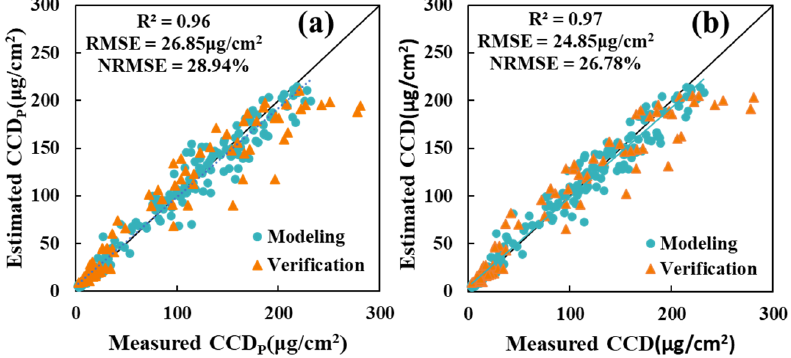
Figure 12. The estimation results of CCD with two different estimation methods using dataset IV. ( a ) The estimation results of CCD P . ( b ) The estimation results of CCD.